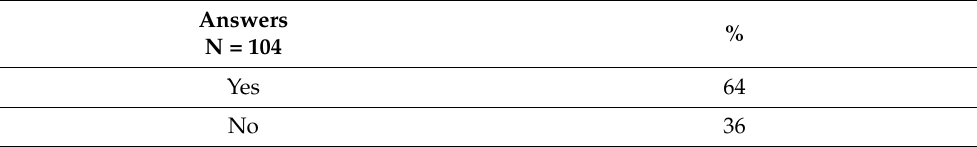
Table 1. Are there any advantages in using AI in your work?